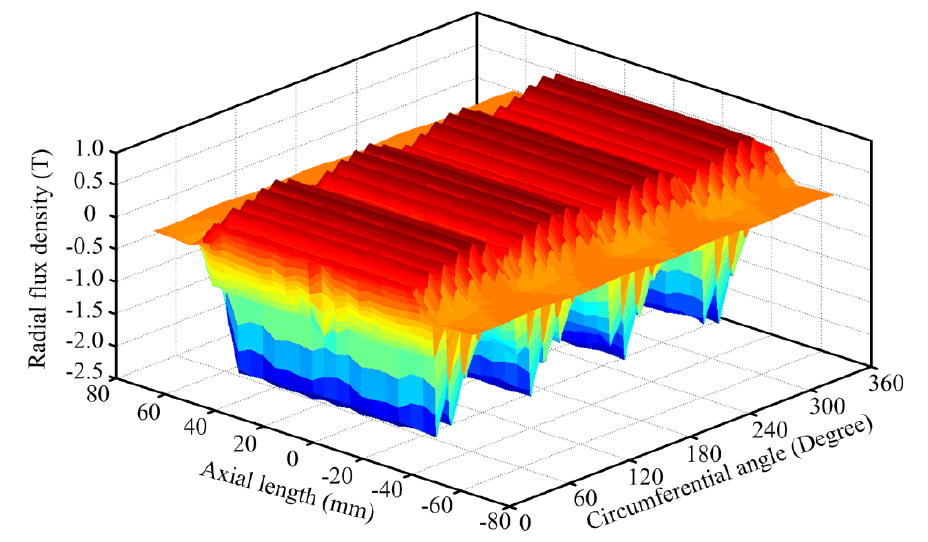
Figure 9. Three-dimensional radial flux density in the air-gap in the optimum